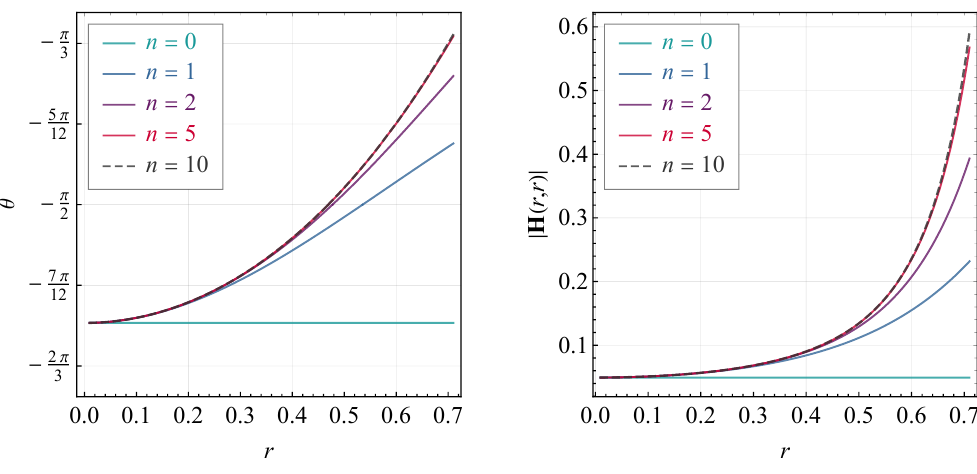
Figure 9 . The convergence of the series in (4.5). We show the result for both the phase and the magnitude of (4.5) by including terms with 0 ≤ n 1 , · · · , n 4 ≤ n , for n = 0 , 1 , 2 , 5 , 10